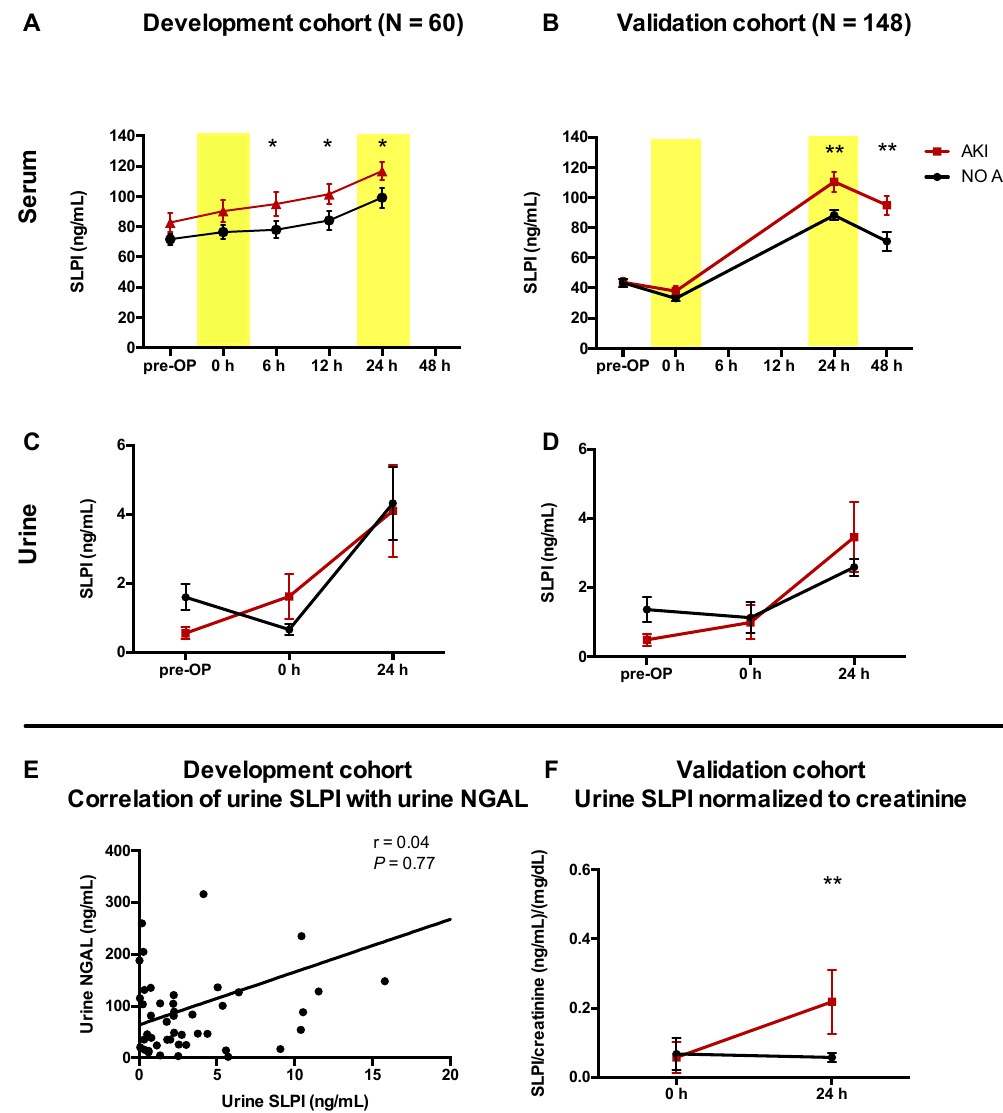
Figure 2. Higher serum SLPI levels were associated with a greater risk of AKI. ( A,B ) Perioperative kinetics of serum SLPI in patients without postoperative AKI compared with patients with AKI. ( C,D ) Perioperative kinetics of urinary SLPI. ( E ) Correlation between postoperative urinary SLPI and postoperative urinary NGAL 24 h after cardiac surgery. ( F ) Postoperative kinetics of urinary SLPI normalized to urinary creatinine. AKI, acute kidney injury; NGAL, neutrophil gelatinase-associated lipocalin; Pre-OP, before surgery; SLPI, secretory leukocyte protease inhibitor. Data are means ± SEM; r , Spearman’s coe ffi cient. ( A , B ) * p < 0.05, ** p < 0.01 versus other groups at the corresponding time point (di ff erence between groups).